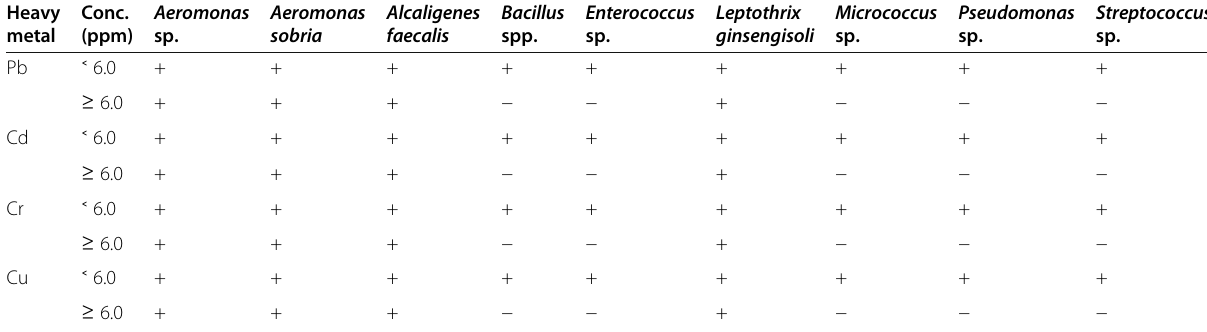
Table 6 Heavy metal tolerance of the bacterial isolates obtained from soil of mining areas in Zamfara State Heavy Conc. Aeromonas metal (ppm) sp.